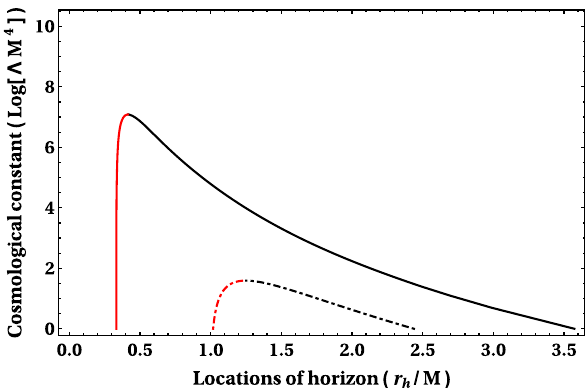
Fig. 1 The location of event horizon (red curve) and cosmological horizon (black curve) for different topologies – solid and dashed curve respectively representing S ( 2 ) × S ( 2 ) and S ( 4 ) . Interestingly, the cut-off on (cid:2) is larger for the spherical case than the product topology, which is due to the additional factor − 2 in the square root. For appropriate scaling of the plots, we have used log ((cid:2) M 4 ) instead of (cid:2) M 4